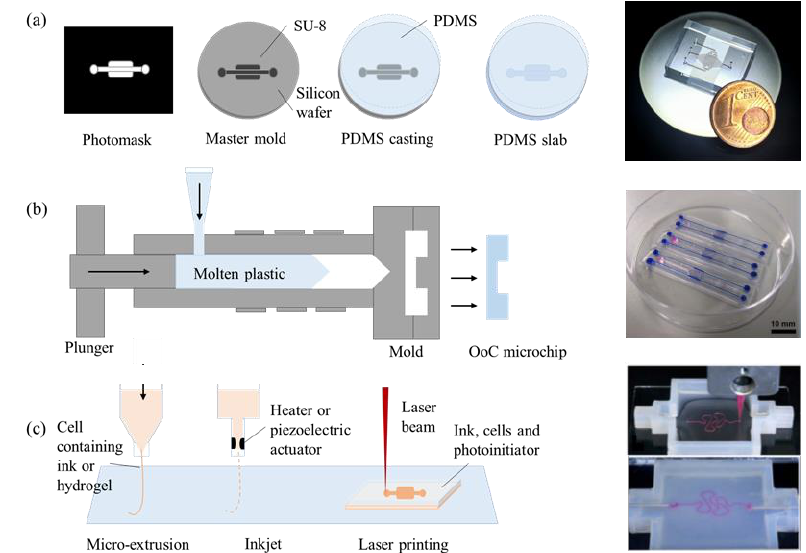
Figure 2. Fabrication methods of organ-on-a-chip models. ( a ) Schematic process of fabricating PDMS-based microfluidic devices. Microchip figure ( right ) reproduced from Ferraz et al., 2018 [11]. ( b ) Schematics and images of an injection molded microfluidic device. Microchip figure ( right ) reproduced from Virumbrales-Munoz et al., 2019 [16]. ( c ) Schematics and images of microchannels fabricated by a 3D printer. Complex-shaped channels can be fabricated with a 3D printer. Microchip figure ( right ) reproduced from Homan et al., 2016 [24].